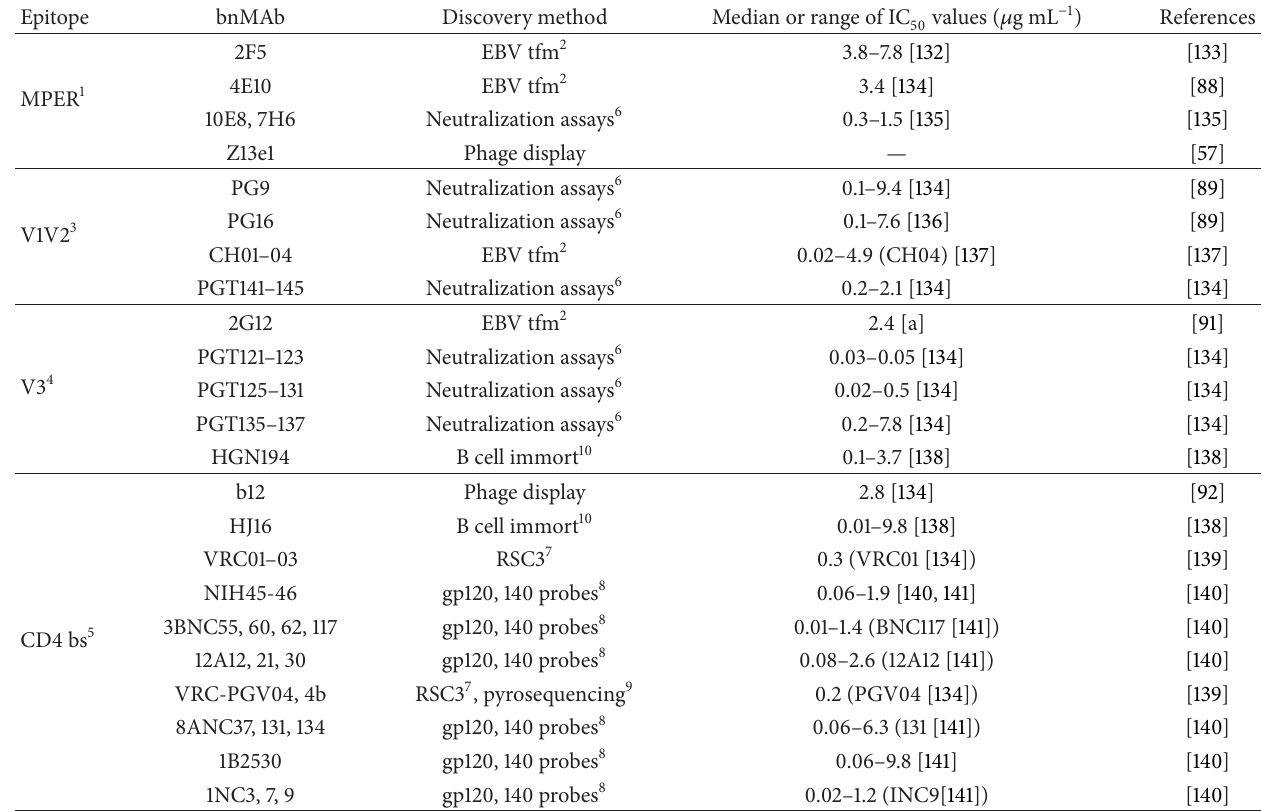
Table 1: Broadly neutralizing monoclonal antibodies (bnMAbs) against